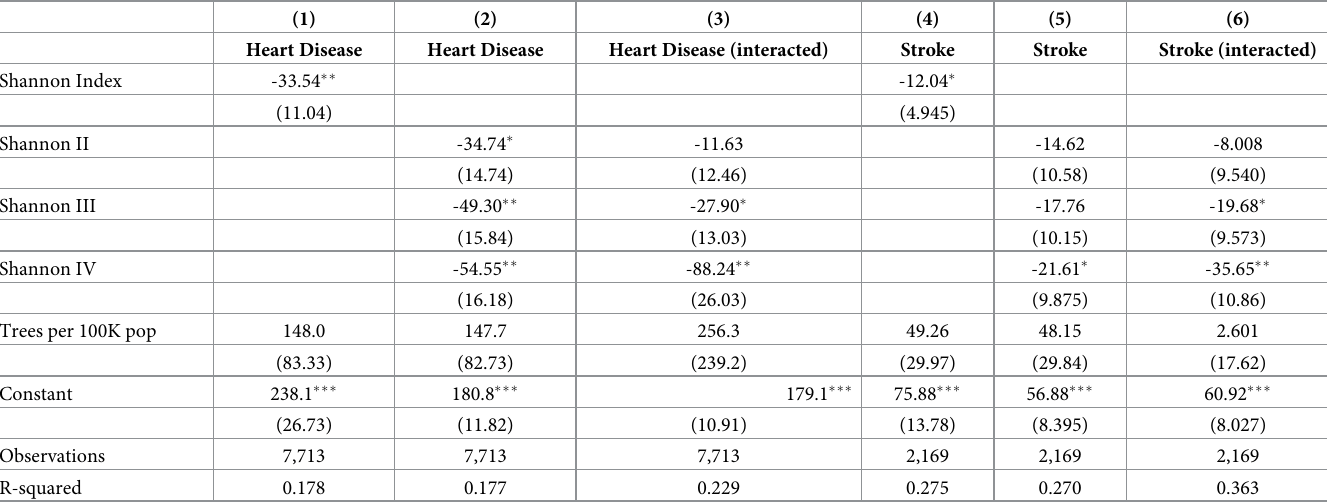
Table 2. Urban forest diversity and mortality.